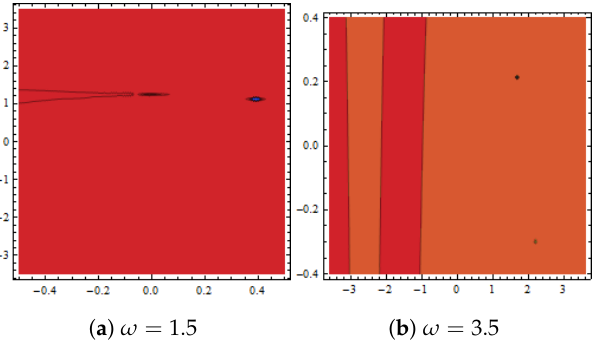
Figure 20. Dynamical demonstration of u ( x , t ) in Equation (50) presented with β 1 = 1.5, β 2 = 0.2, β 3 = 0.5, ζ = 0, l 1 = 1.1, l 2 = 0.1, l 4 = 0.5, Q = 1.2, r 1 = 2.5, r 2 = 0.12, w 2 = 0.2, w 3 = 0.03, w 4 = 3.1 and φ = 1.4. ( a , b ) show contour plots for different ω .